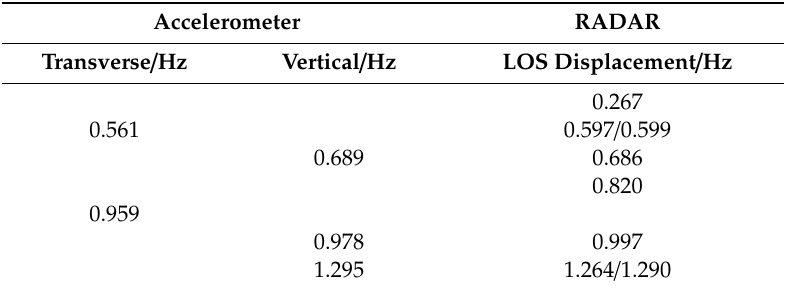
Table 3. Frequency values obtained from radar data, compared to accelerometer results.